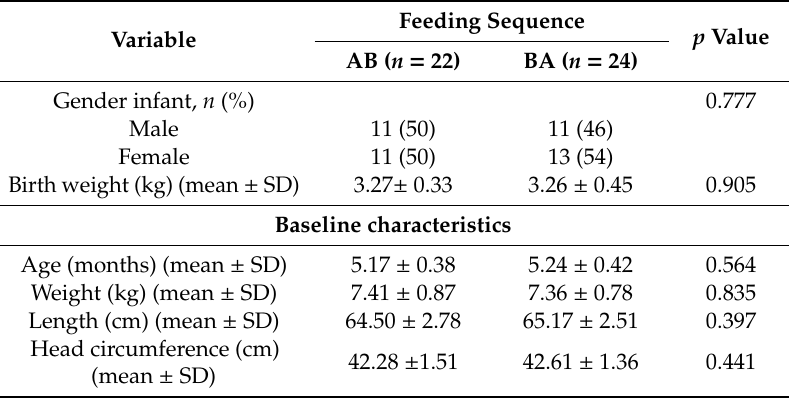
Table 2. Subjects characteristics at birth and enrolment .